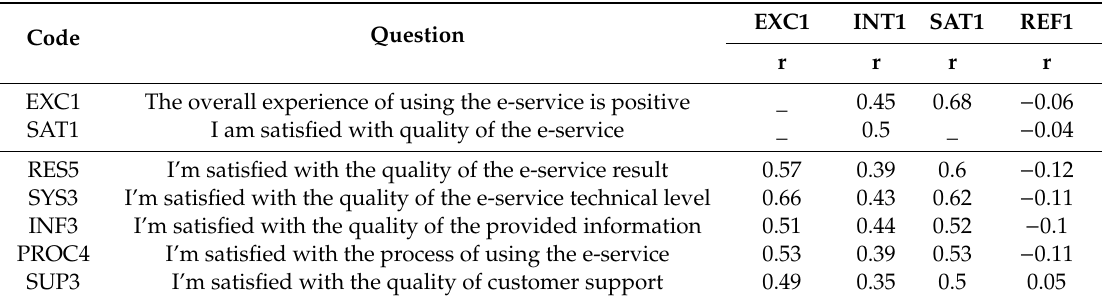
Table 5. Correlation relationships of the key components of the